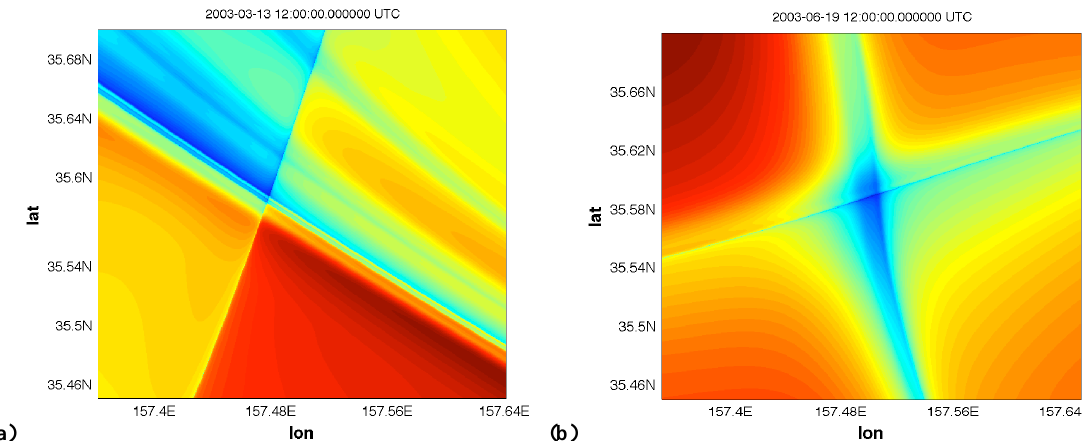
Fig. 2. Structure of the function M for τ = 15, (a) in the neighbourhood of the western DHT, DHT W , on 13 March 2003; and (b) in the neighbourhood of the eastern DHT, DHT E , on 19 June